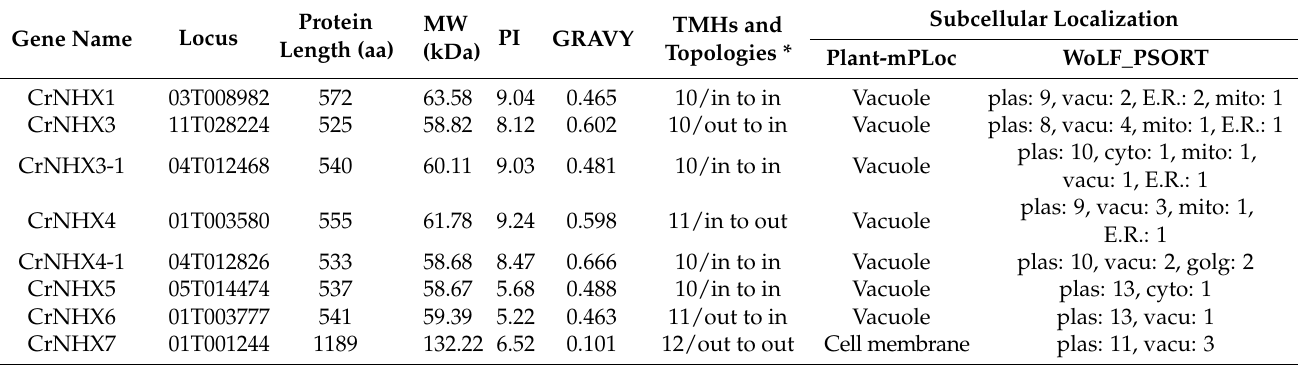
Table 1. Nomenclature and subcellular localization of CrNHXs identified from C. rosea genome. MW: molecular weight; PI: isoelectric point; GRAVY: grand average of hydropathicity; TMH: trans- membrane α -helix.